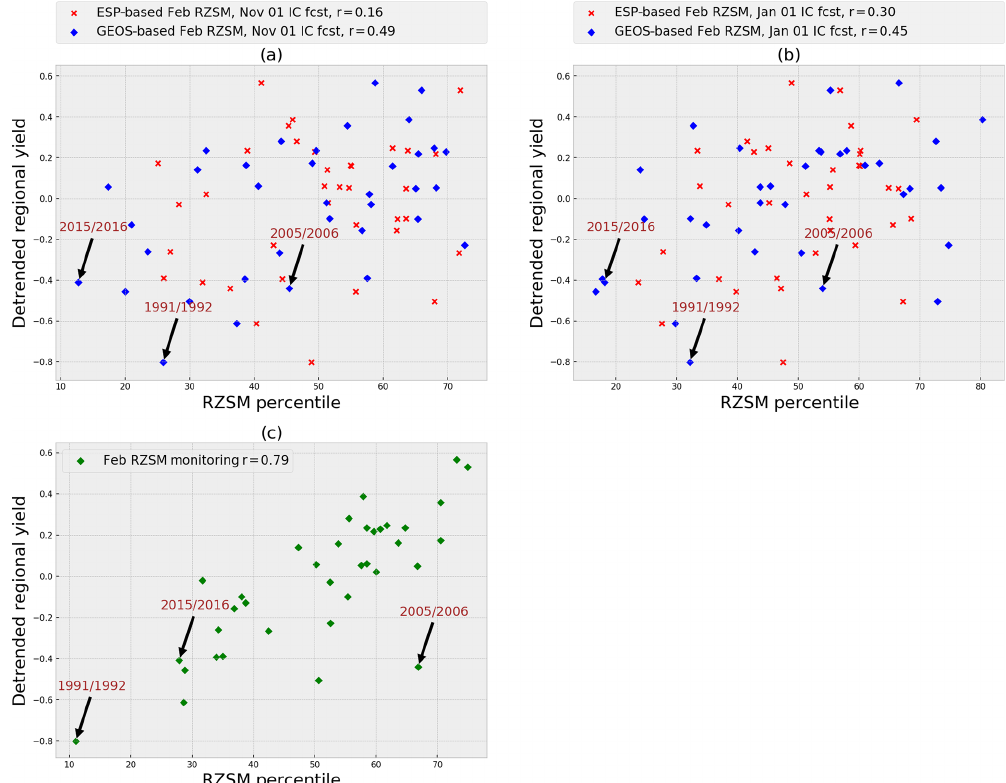
Figure 6. Covariability of detrended regional yield in southern Africa, with (a) February RZSM forecasts (initialized on 1 November) generated using ESP method and bias-corrected GEOS forecasts, (b) February RZSM forecasts (initialized on 1 January) generated using ESP method and bias-corrected GEOS forecasts, and (c) the February RZSM monitoring product (available in early March). IC fcst stands for initial condition of